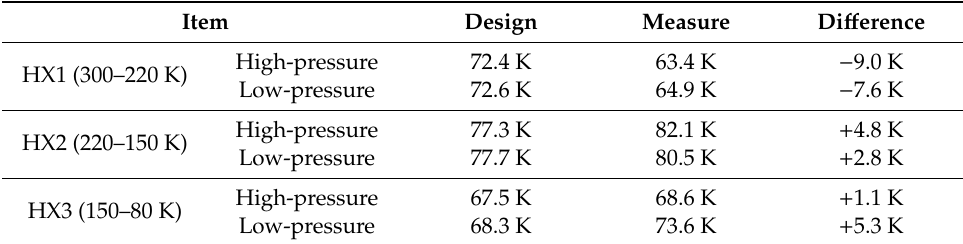
Table 5. Temperature di ff erence between the inlet and outlet of each heat exchanger unit. Item Design Measure Di ff erence High-pressure 72.4 K 63.4 HX1 (300–220 K)